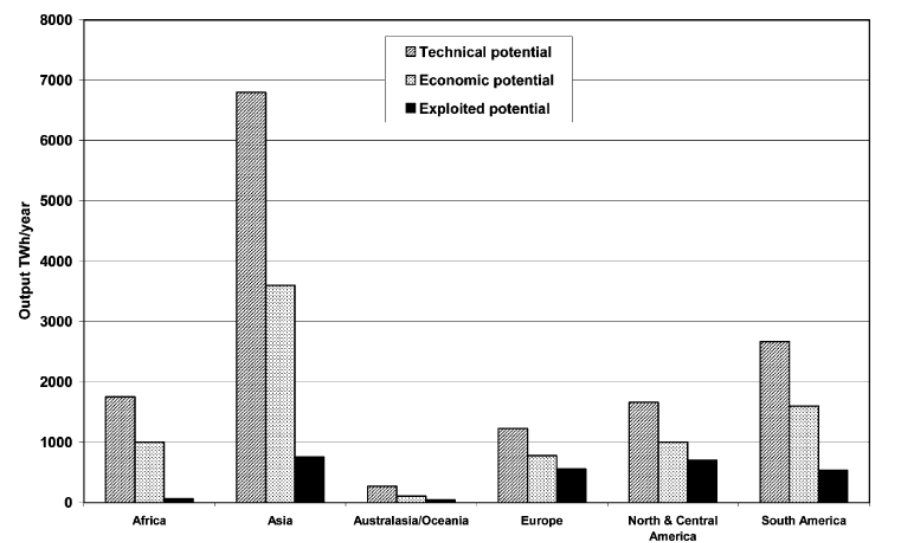
Figure 36. Technical, economic and exploited hydro potential by continent [164]. © 2002 Elsevier, reproduced with